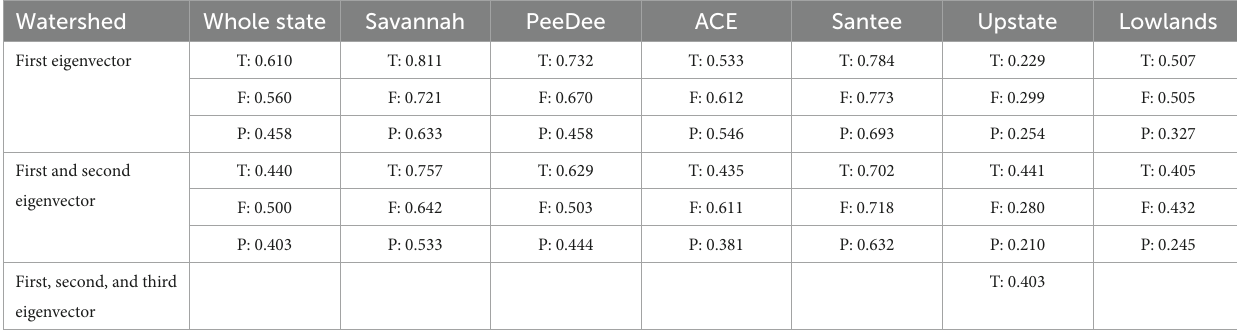
TABLE 4 Adjusted R 2 values for first and second eigenvectors to be used in variation partitioning of stream fish